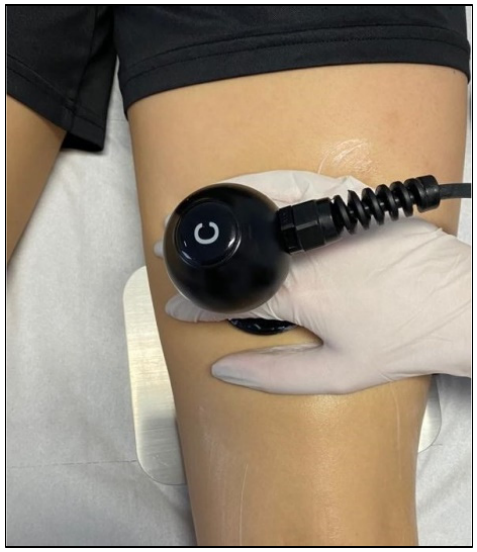
Figure 5. TECAR therapy in the treatment of hamstring muscles.